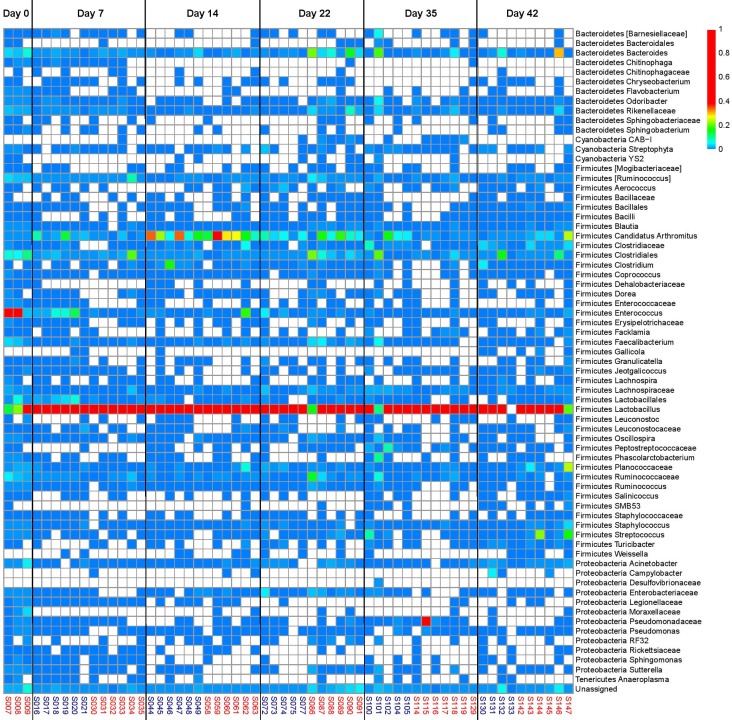
Heatmap of taxonomic groups present in the ileum of birds fed on BMD-diet and BMD-free diet (control group) across all ages (d0, 7, 14, 22, 35 and 42).The sample numbers (n = 6 for each time point) in red are of control diet and blue are of BMD diet.